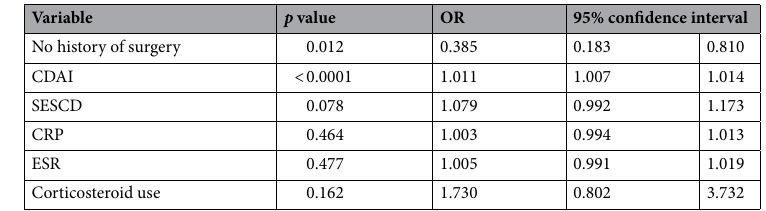
Table 4. Predictors of symptoms of anxiety and depression in CD patients. CD Crohn’s disease, CDAI Crohn’s disease activity index, SES-CD Simple Endoscopic Score for Crohn’s disease, ESR erythrocyte sedimentation rate, CRP C-reactive protein, OR odds